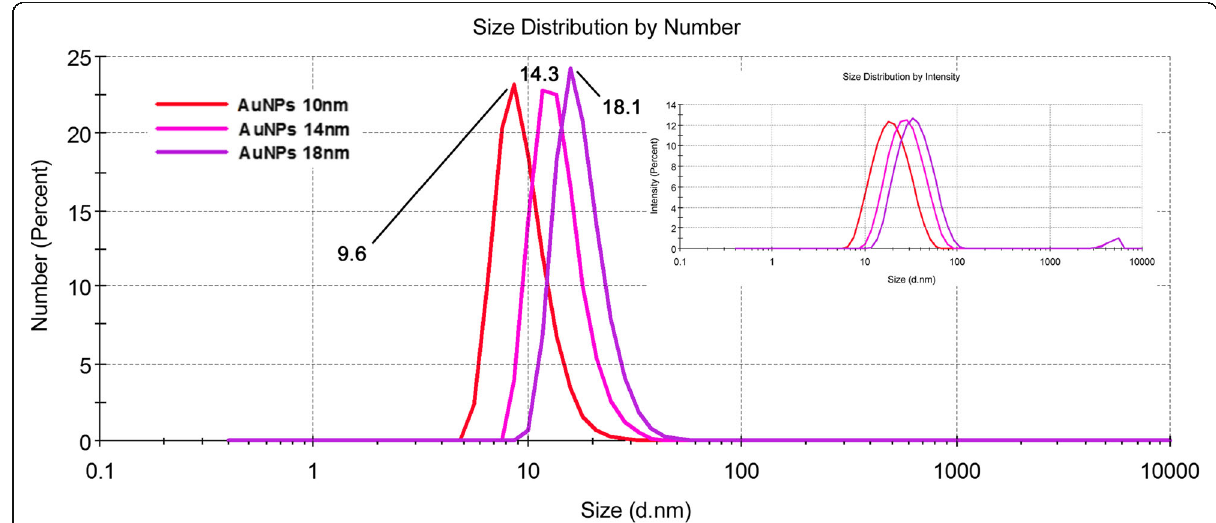
Fig. 1 Dynamic light scattering analysis (number weighted size distribution) of aqueous solutions of AuNPs of different sizes. Inset shows “ raw ” intensity-weighted data. Numbers refer to average particle diameter in